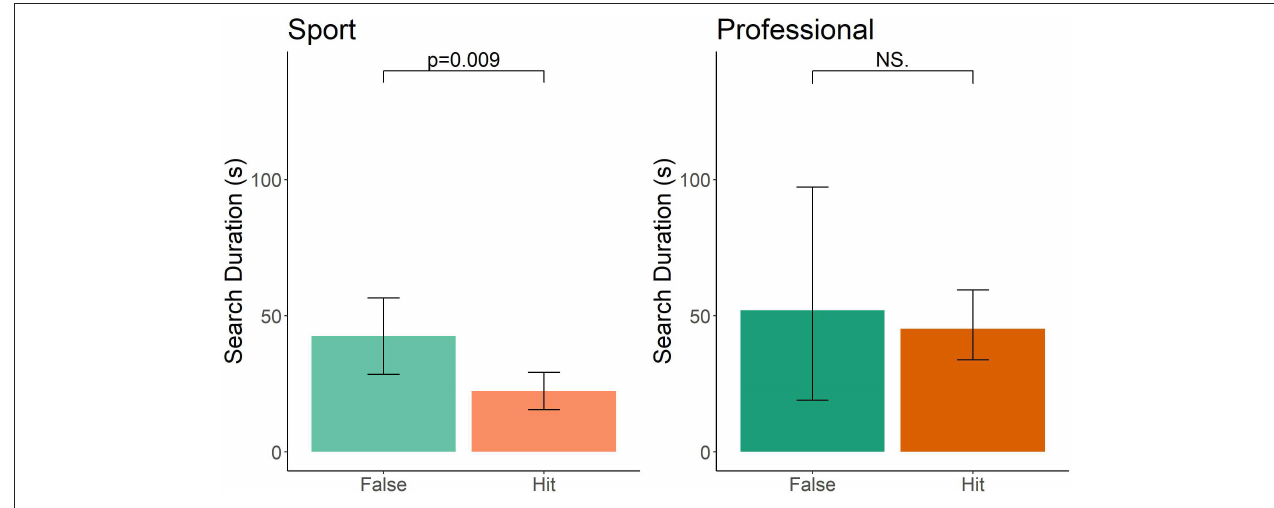
FIGURE 3 | Time of search until either a hit or false alert is called in sport and professional handler dog teams. Error bars represent 95% confidence intervals.